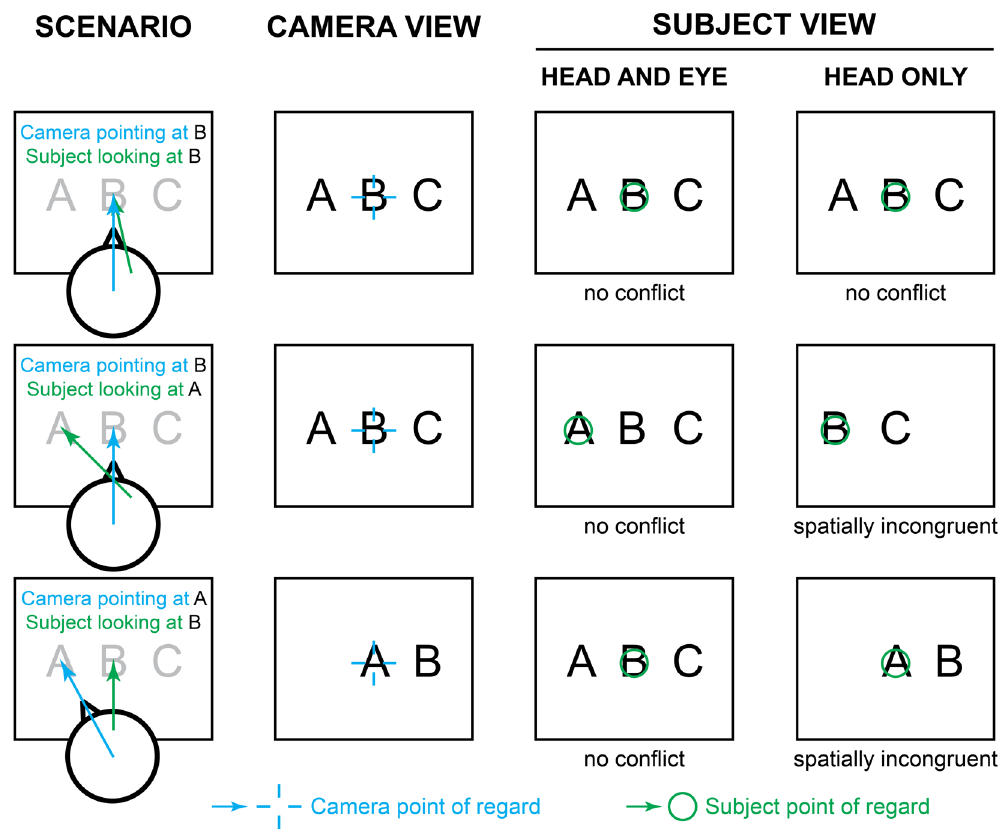
Figure 1. Gaze conditions and the problem created by ignoring eye position. In the general case where the eyes are not used to image the external world in a visual prosthesis, there is potential for the camera axis, typically steered by head position, and the gaze location, determined by the combination of head position and eye position within the head, to be out of agreement. This figure depicts three conditions, by row, the first where the gaze (blue) and camera (green) are aligned, pointing forward (top row), the second where the head and camera are in the same positions, but the eyes have deviated to the left (middle row), and the third where the head and camera have been turned to the left, but the eyes have counter-rotated to the right such that gaze is once again straight ahead (bottom row). The second column from the left shows the image that the camera sees. The third column depicts what is perceived when the prosthesis includes compensation for gaze location (Head and Eye, or Full Gaze), with congruent stimulation resulting in a perception that is spatially stable. The fourth column depicts what is perceived by the subject where the prosthesis delivers the image from the uncompensated camera (as in head-steered devices), but the brain continues to apply its knowledge about eye position, creating spatially incongruent conditions whenever the camera and eyes are not pointing in the same